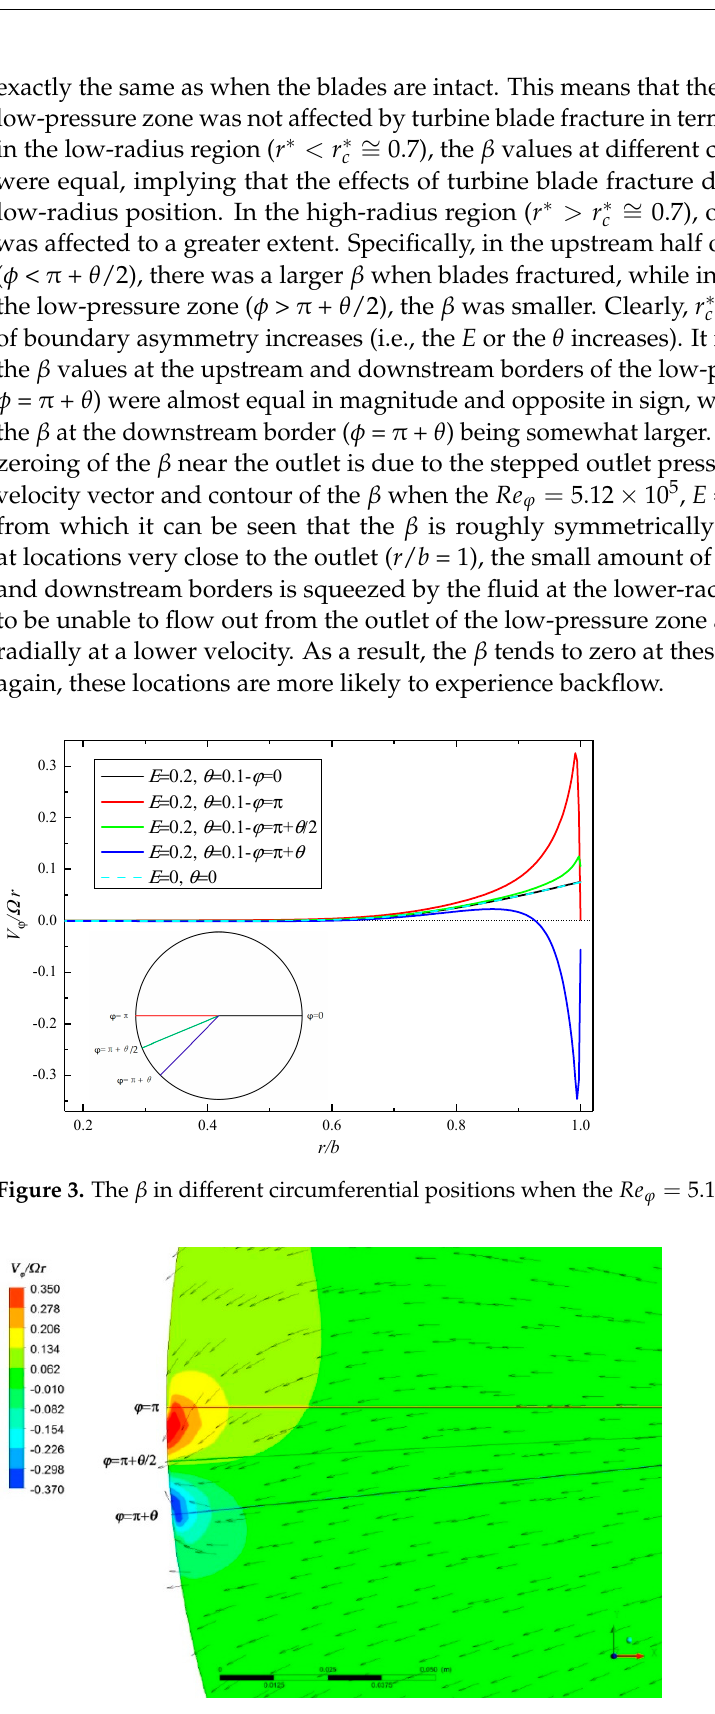
Figure 4. Velocity vector and contour of the β when the Re ϕ = 5.12 × 10 5 , E = 0.2, θ = 0.1 at z / s = 0.5.